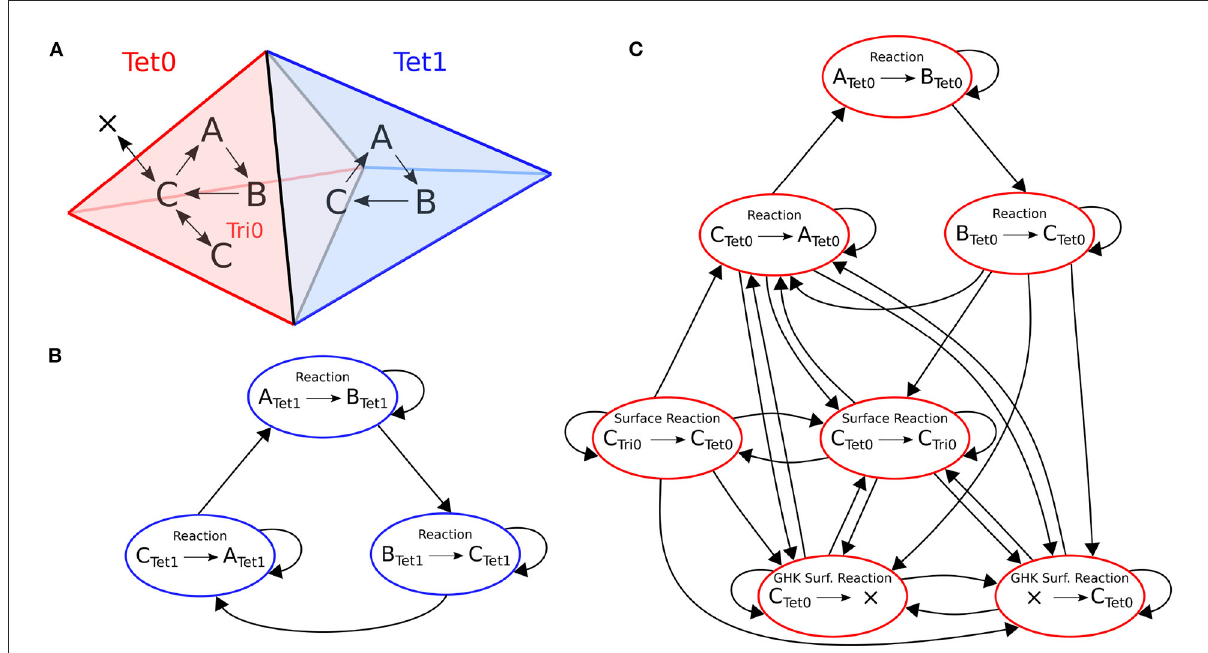
FIGURE3 Structure of the reaction dependencies graph on a mesh with two connected tetrahedrons labeled 0 and 1. (A) The two tetrahedrons and the reactions they contain. Both tetrahedrons contain reactions A → B , B → C and C → A . Tetrahedron 0 also contains four surface reactions: Species C can be transferred back and forth to a triangle ( C tet → C tri and C tri → C tet ); and species C can cross the membrane back and forth as a GHK current (since the amount of C outside of tetrahedron 0 is not modeled, it is equivalent to creating and removing species C ). (B,C) The corresponding reaction dependencies graphs. Each colored node represents a kinetic process. An arrow goes from one node to the other if the occurrence of an event of the first entails a change in propensity of the second. In blue and red are the extracted connected components of the